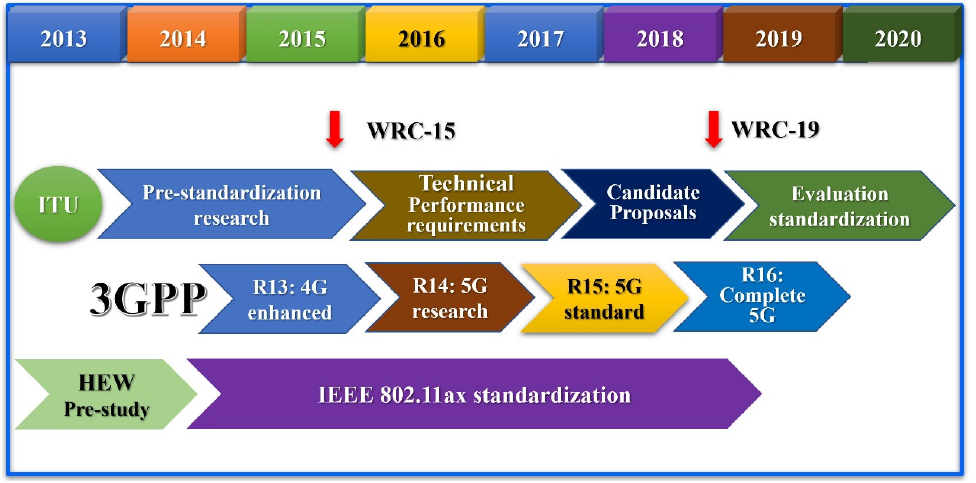
Figure 7. Fifth generation (5G) standardization timeline.